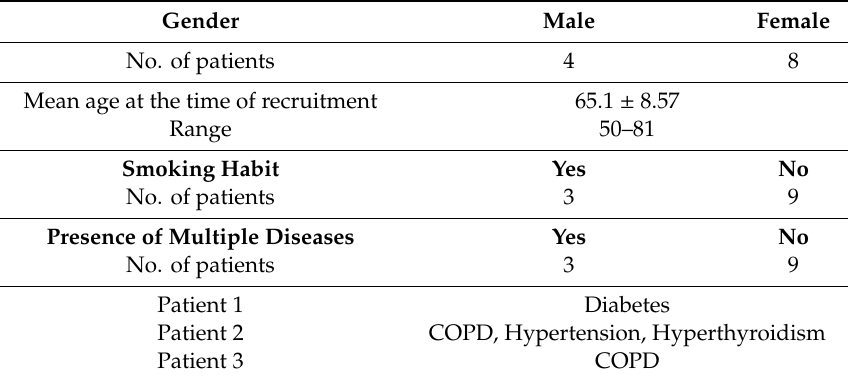
Table 1. Description of the